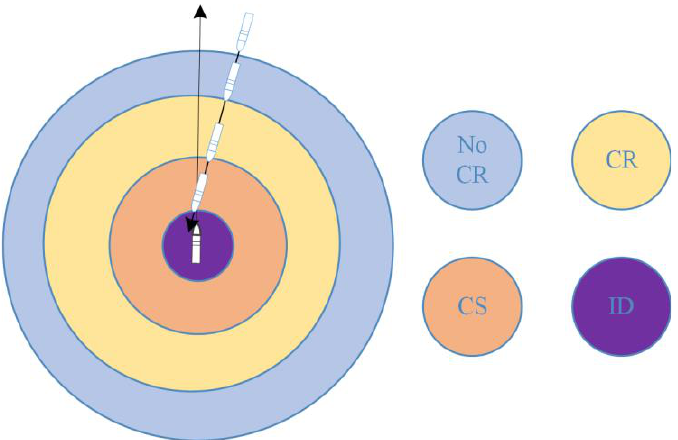
Figure 2. The diagram of the four-Stage